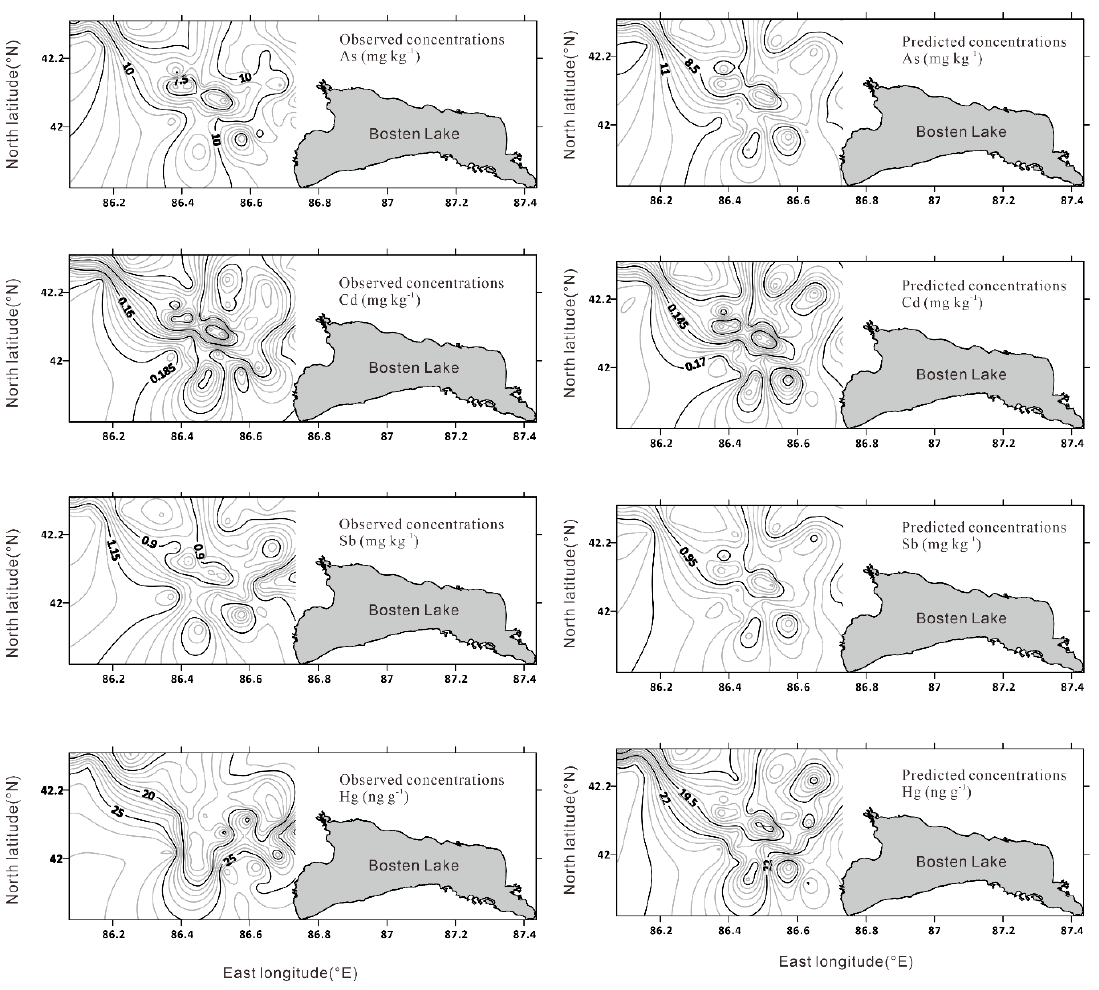
Figure 4. Geographically weighted regression predicted concentrations of potentially toxic elements compared with the observed/measured values in the Bosten Lake region. compared with the observed / measured values in the Bosten Lake Table 2. General performance ratings for the results of the geographically weighted regression and multiple classical linear models for potentially toxic elements (PTEs).